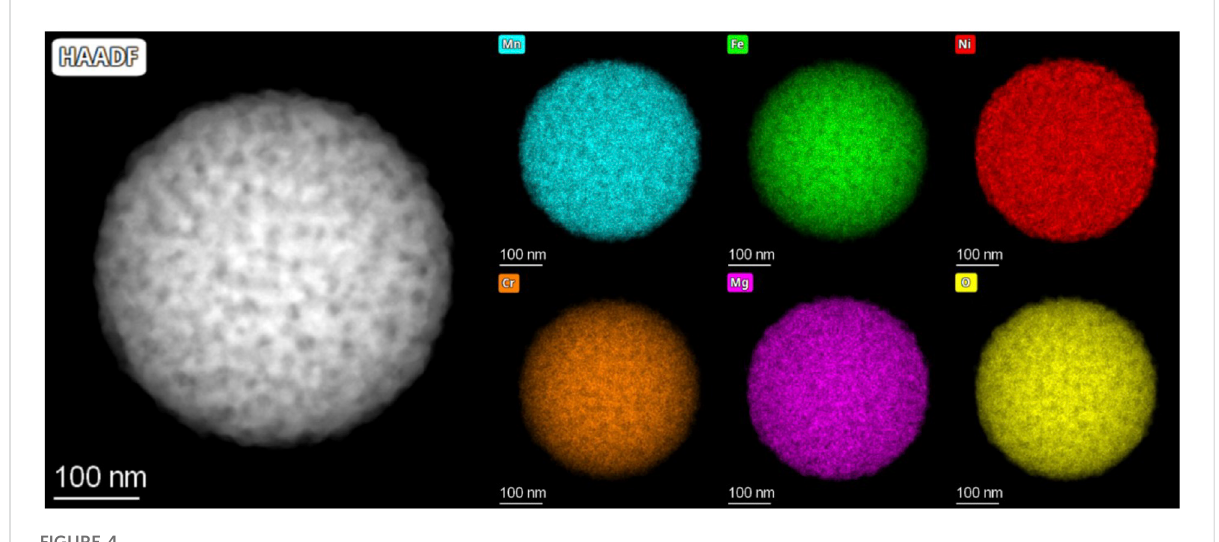
FIGURE 4 STEM-EDX mapping of HESp2. All elements are distributed